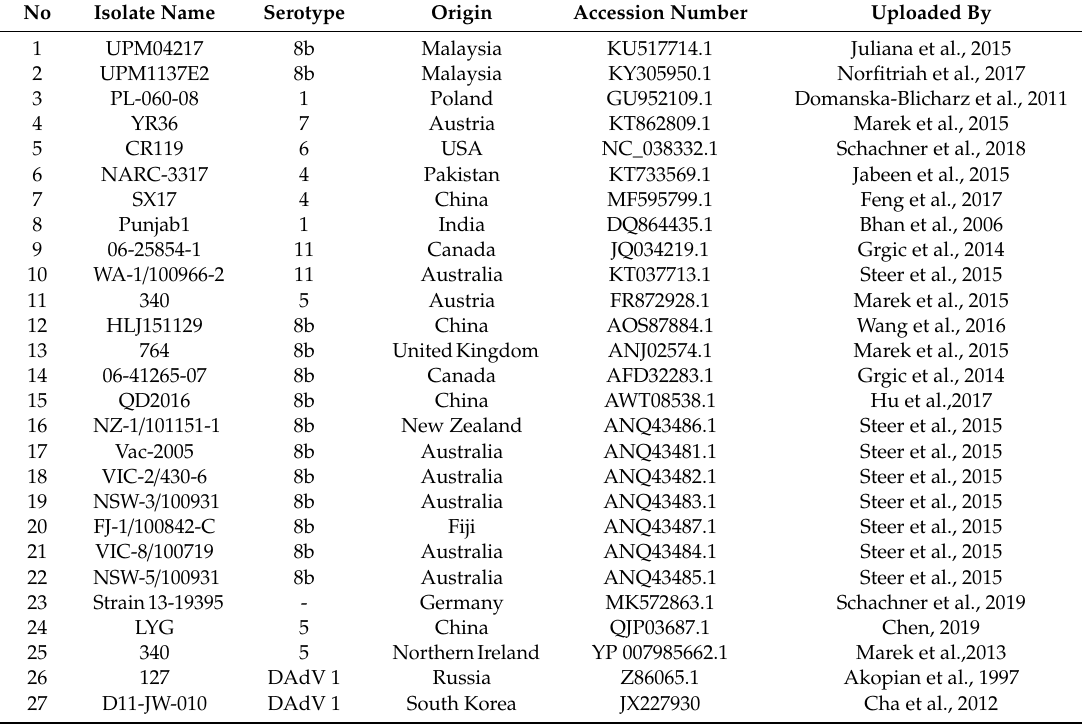
Table 3. The aviadenovirus reference strains obtained from Genebank used in the construction of phylogenetic tree for fibre gene